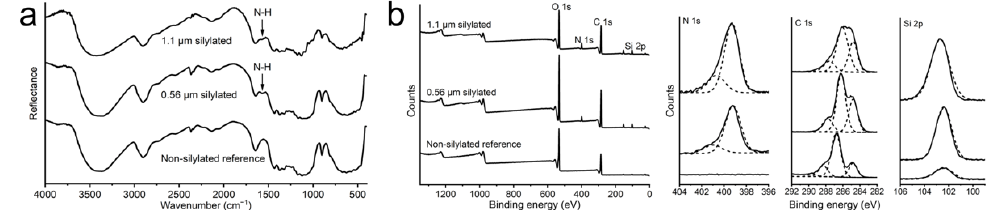
Figure 5. DRIFT and XPS spectra. ( a ) DRIFT and ( b ) XPS spectra of the CNF filament mats.